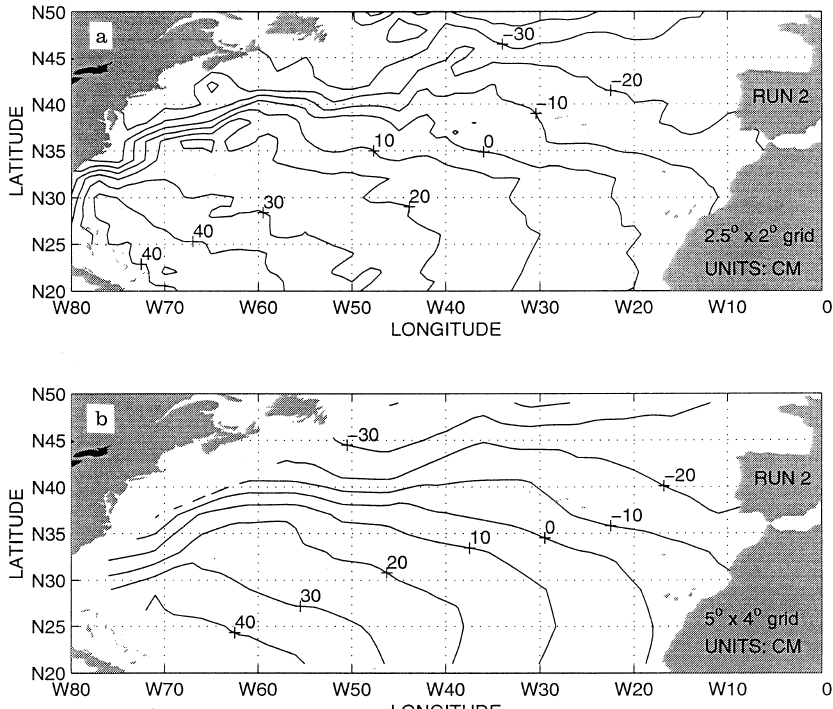
Fig. 7. a Mean dynamic topography (cm) on the 2.5 (cid:176) (cid:180) 2 (cid:176) grid estimated by the inverse model constrained by dynamical equations, hydrographic observations, and altimetric observations (run 2). b Same as a but the mean dynamic topography is averaged onto the 5 (cid:176) (cid:180) 4